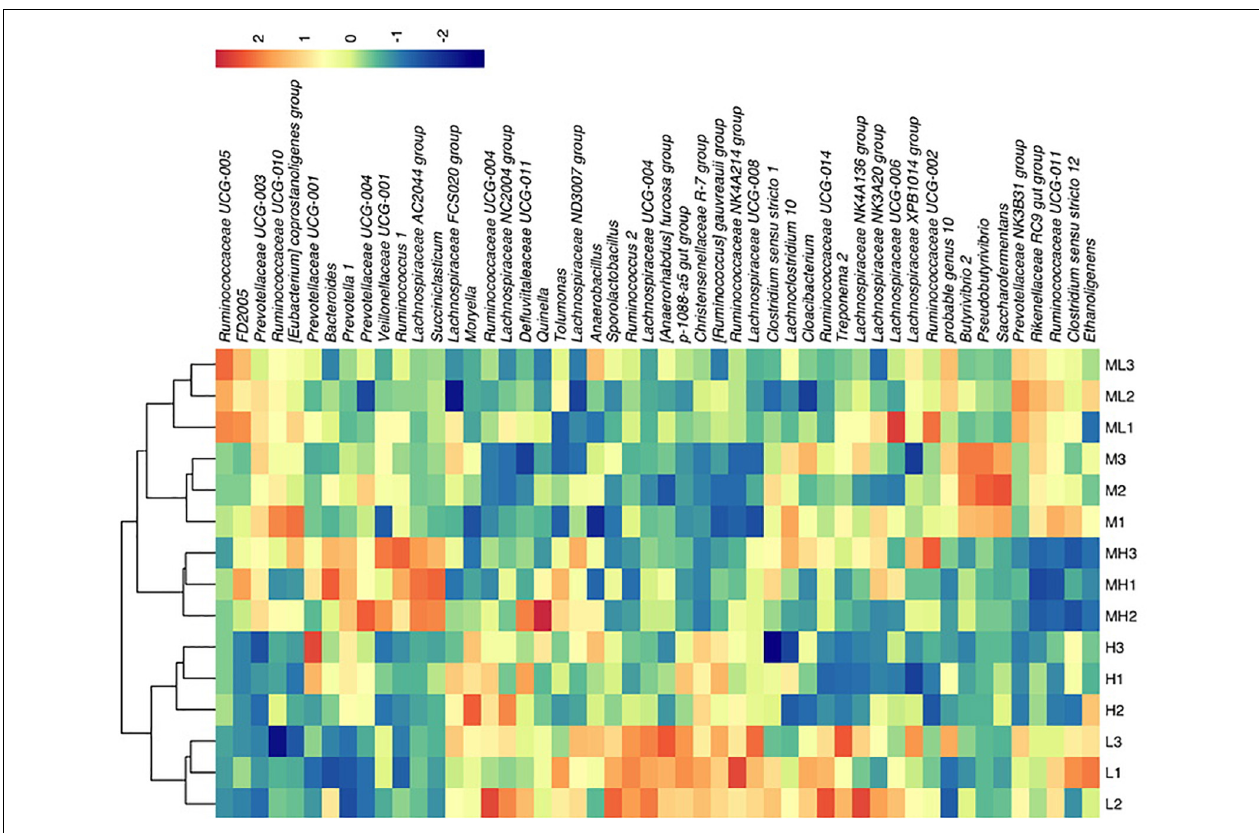
FIGURE 5 | Heat map of species abundance at the genus level (top 50 bacteria). H group: 33.0% peNDF 1 . 18 treatment. MH group: 29.9% peNDF 1 . 18 treatment. M group: 28.1% peNDF 1 . 18 treatment. ML group: 26.5% peNDF 1 . 18 treatment. L group: 24.8% peNDF 1 . 18 treatment. The abscissa is sorted according to the order of the samples, and the ordinate is arranged according to the total average abundance from top to bottom. The relative abundance of the genus is not converted, and the legend shows the percentage. The redder color represents higher abundance, and the bluer color represents lower